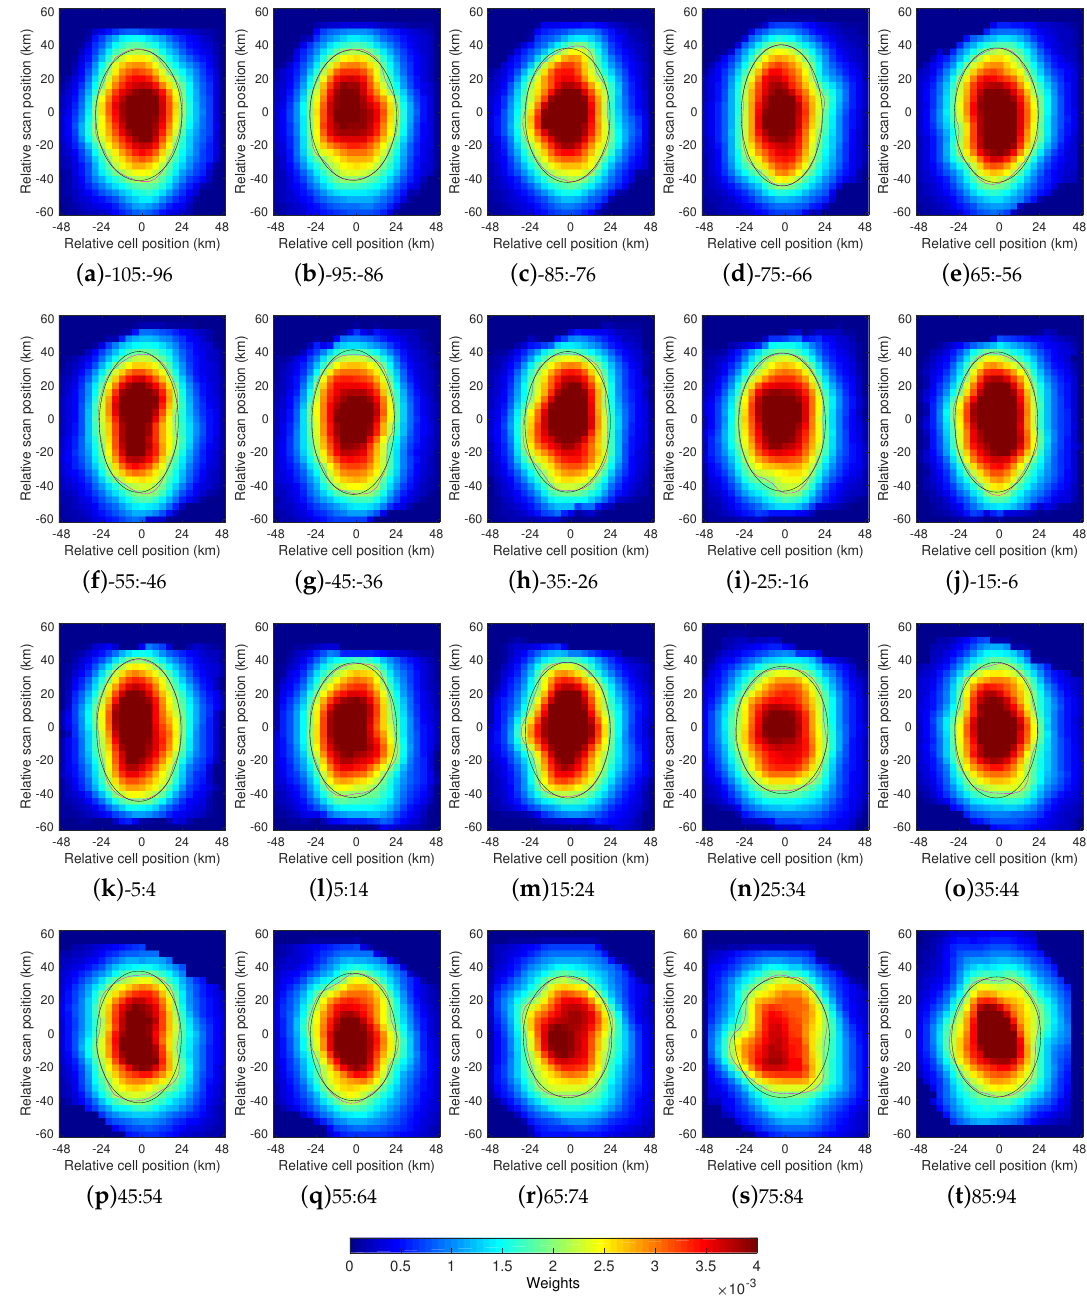
Figure 9. Estimated AMSR-E footprints obtained by projecting the footprints in Figure 8 on regular 4 km × 4 km grids aligned with the instantaneous AMSR-E field-of-view (a 4 × 4 moving averaged filter was applied prior the calculation). A contour-line at 0.002 level (magenta) and its best fitting ellipse (black) are traced for each